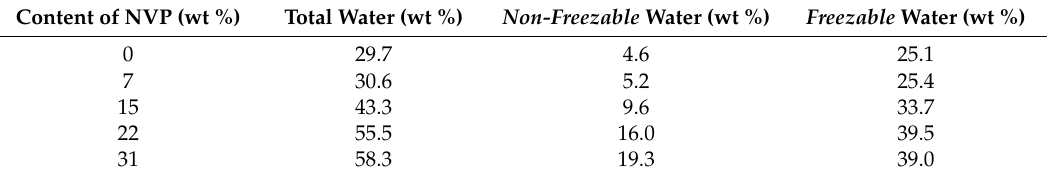
Table 3. Water content of total, non-freezable and freezable water in PANcNVP. Extracted from [79]. Content of NVP (wt %)